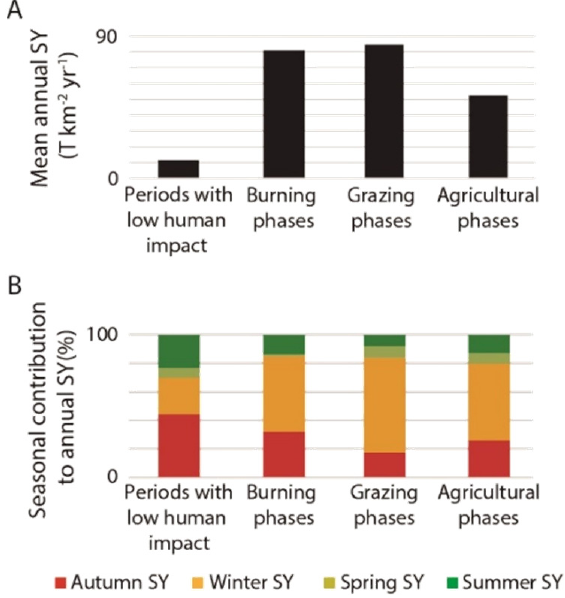
Figure 12. ( A ) Mean annual sediment yield (SY) provided by flood events from the catchment to Lake Montcortès during the different cultural landscape changes. ( B ) Relative seasonal contribution to annual sediment yield (%) The different land use phases have been reconstructed from a multi- proxy approach combining coprophilous fungi, pollen and charcoals (modified from Corella et al., 2019 [140]).